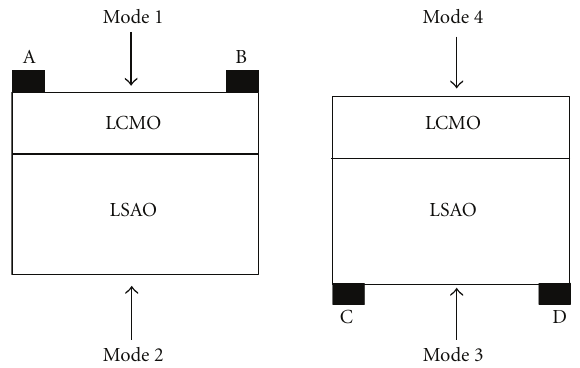
Figure 1: Schematic illustration of photoelectrical experiment on LCMO/LSAO sample.